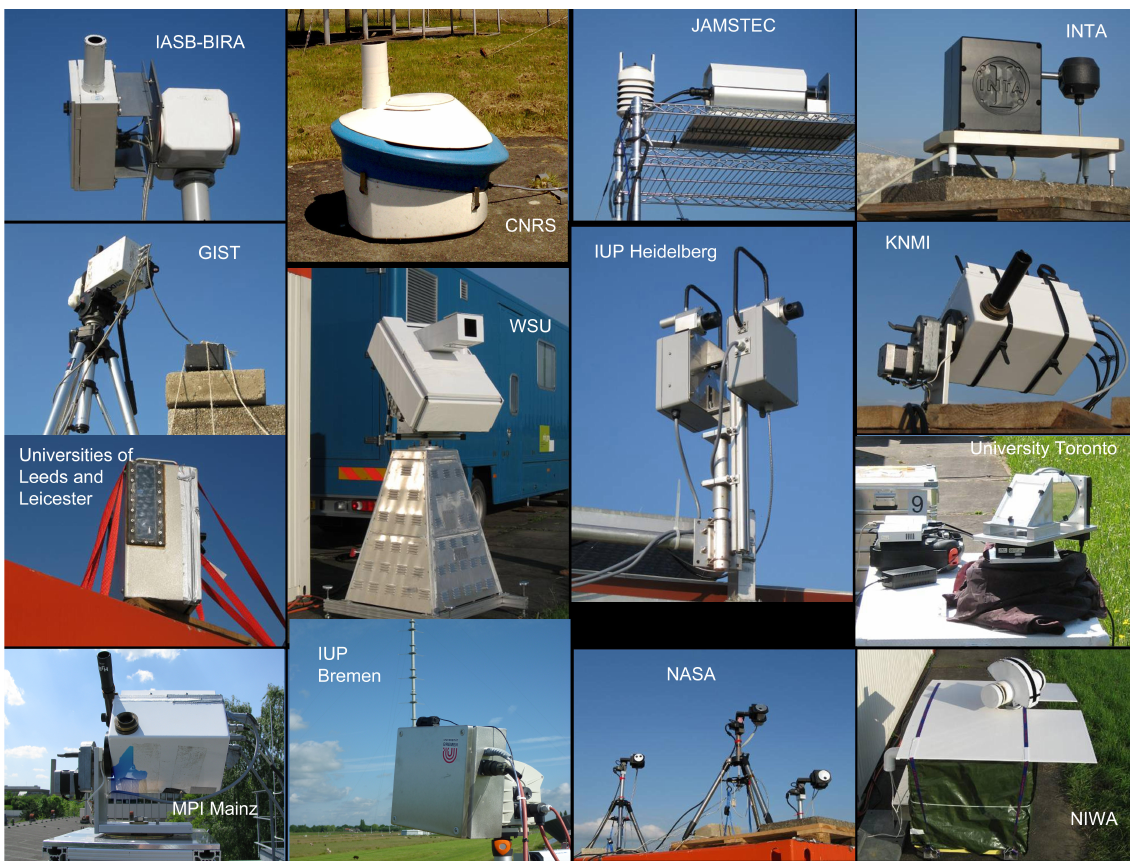
Fig. 3. Snapshots of the various optical instruments installed at the remote sensing site indicating the large variety of optical detection system designs actively involved in the campaign effort. Some images display complete stand-alone systems (e.g. WSU), others are only displaying the telescopes (e.g. NASA) that are connected to the spectrographs and detection systems by optical quartz